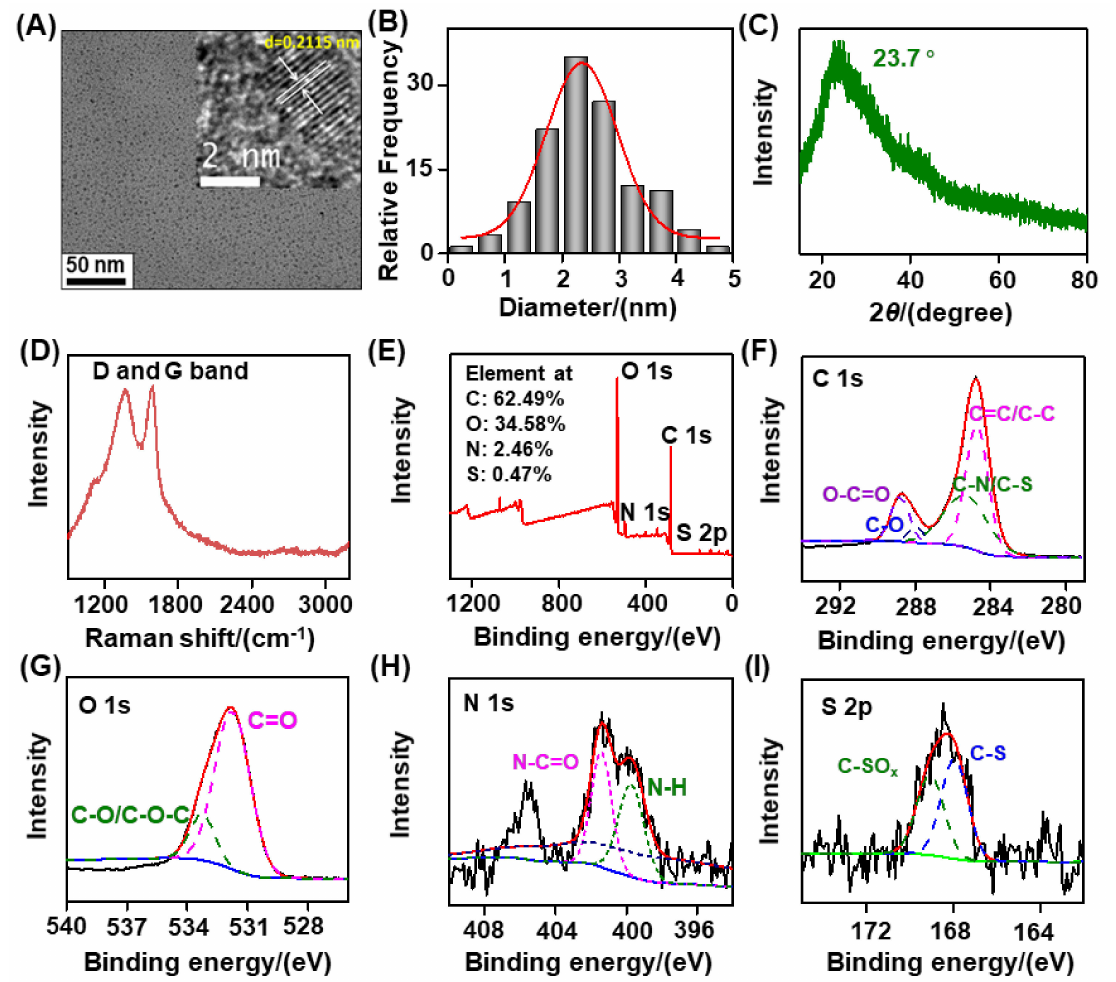
Figure 2. Characterization of the synthesized biomass − based C − dots. ( A ) TEM image, ( B ) size distribution, ( C ) XRD pattern, ( D ) Raman spectrum, ( E ) XPS survey, ( F ) C 1s, ( G ) O 1s, ( H ) N 1s, and ( I ) S 2p high − resolution spectra of the biomass-based C − dots. Inset of Figure 2A is the HRTEM image of the biomass − based C −